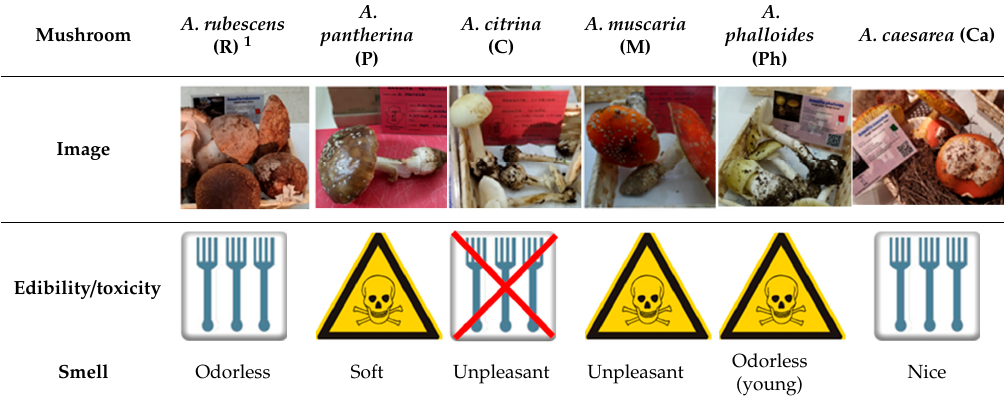
Table 2. Most significant vegetation type and collection areas.